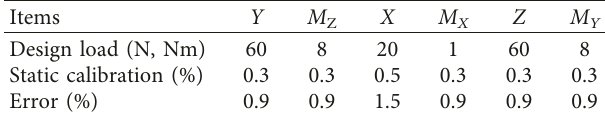
Table 2: Scale and precision of TG0151 balance.